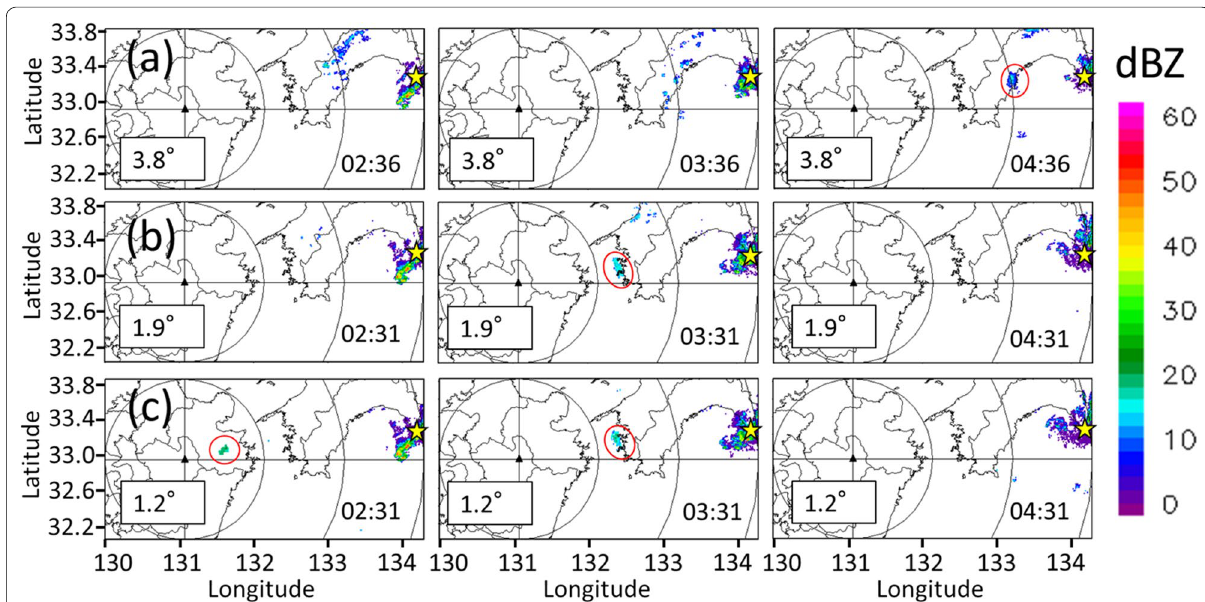
Fig. 4 Eruption cloud echo (red ellipse) observed by Muroto-misaki radar (yellow star) (from 2:31 to 4:36 JST, October 8, 2016). Elevation angles are a 3.8 (upper row), b 1.9 (middle row) and c 1.2 degrees (bottom row). Concentric circles represent 100, 200 and 300 km from Mt. Aso ( ▲